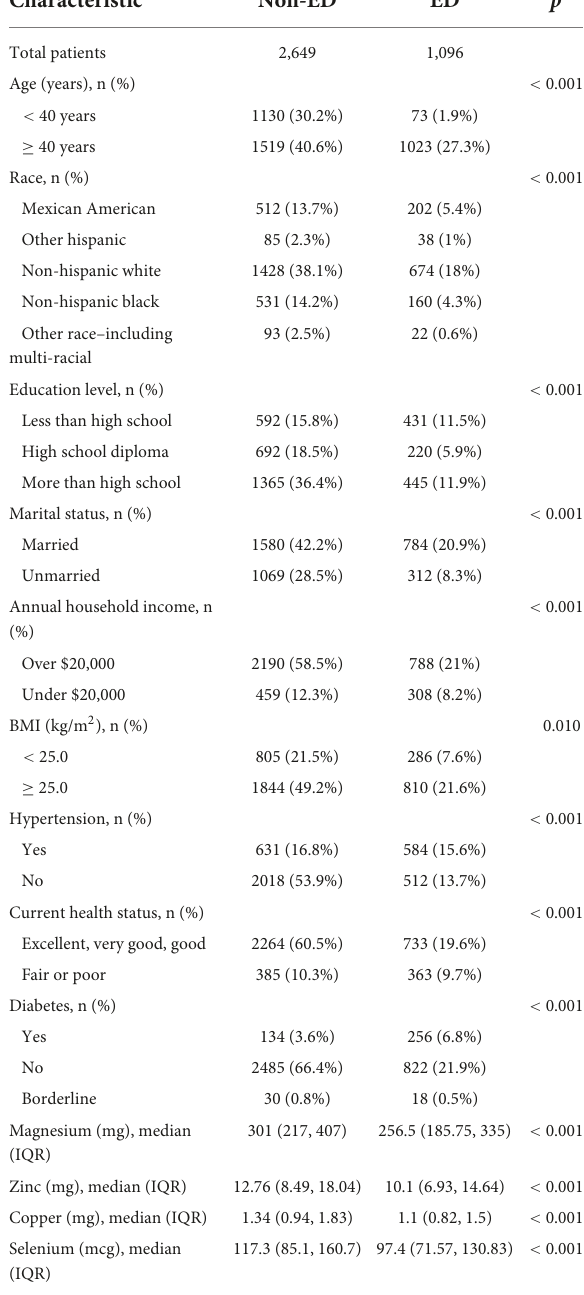
TABLE 1 Baseline characteristics of national health and nutrition examination survey (NHANES) participants between 2001 and 2004 before propensity score matching